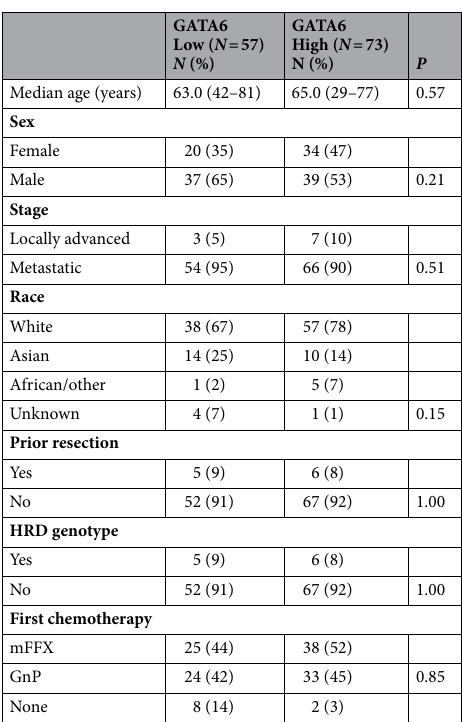
GATA6 Low ( N = 57) N (%)